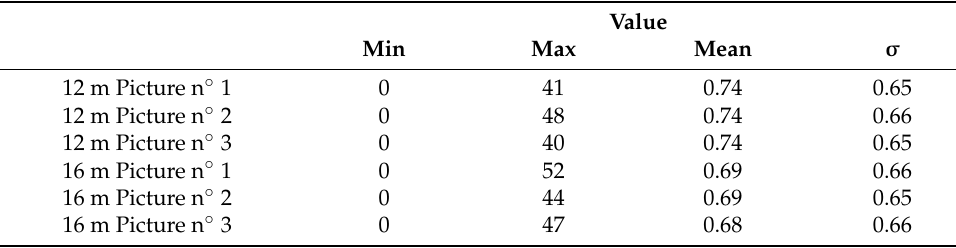
Table 2. Description of SI results for each image.